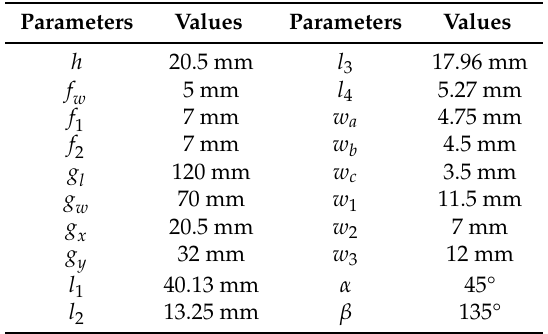
Table 1. Optimized geometric parameters of the proposed